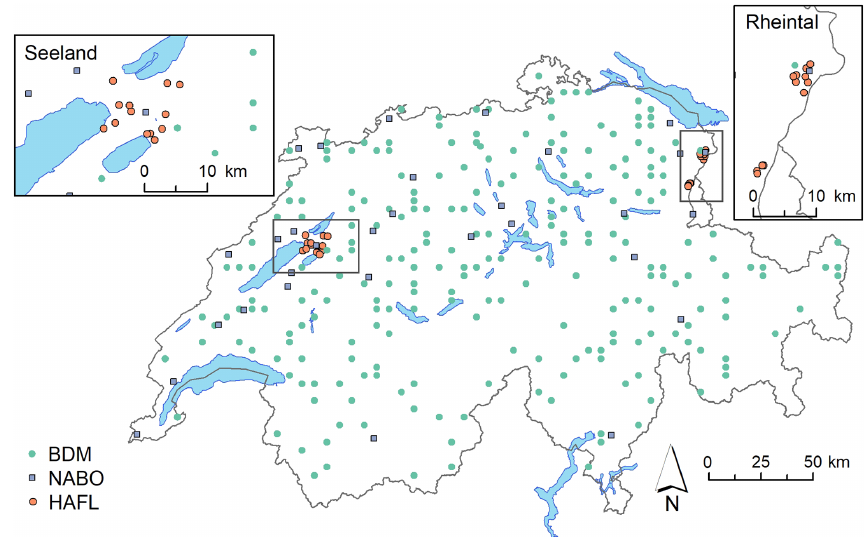
Figure E1. A map showing BDM (green dots) and NABO (gray squares) locations from which RS-LOCAL subset samples ( n =314, k = 300) for a RS-LOCAL calibration ( n = 334). All HAFL locations (orange dots) are shown underneath BDM and NABO locations to allow a better focus on locations chosen by